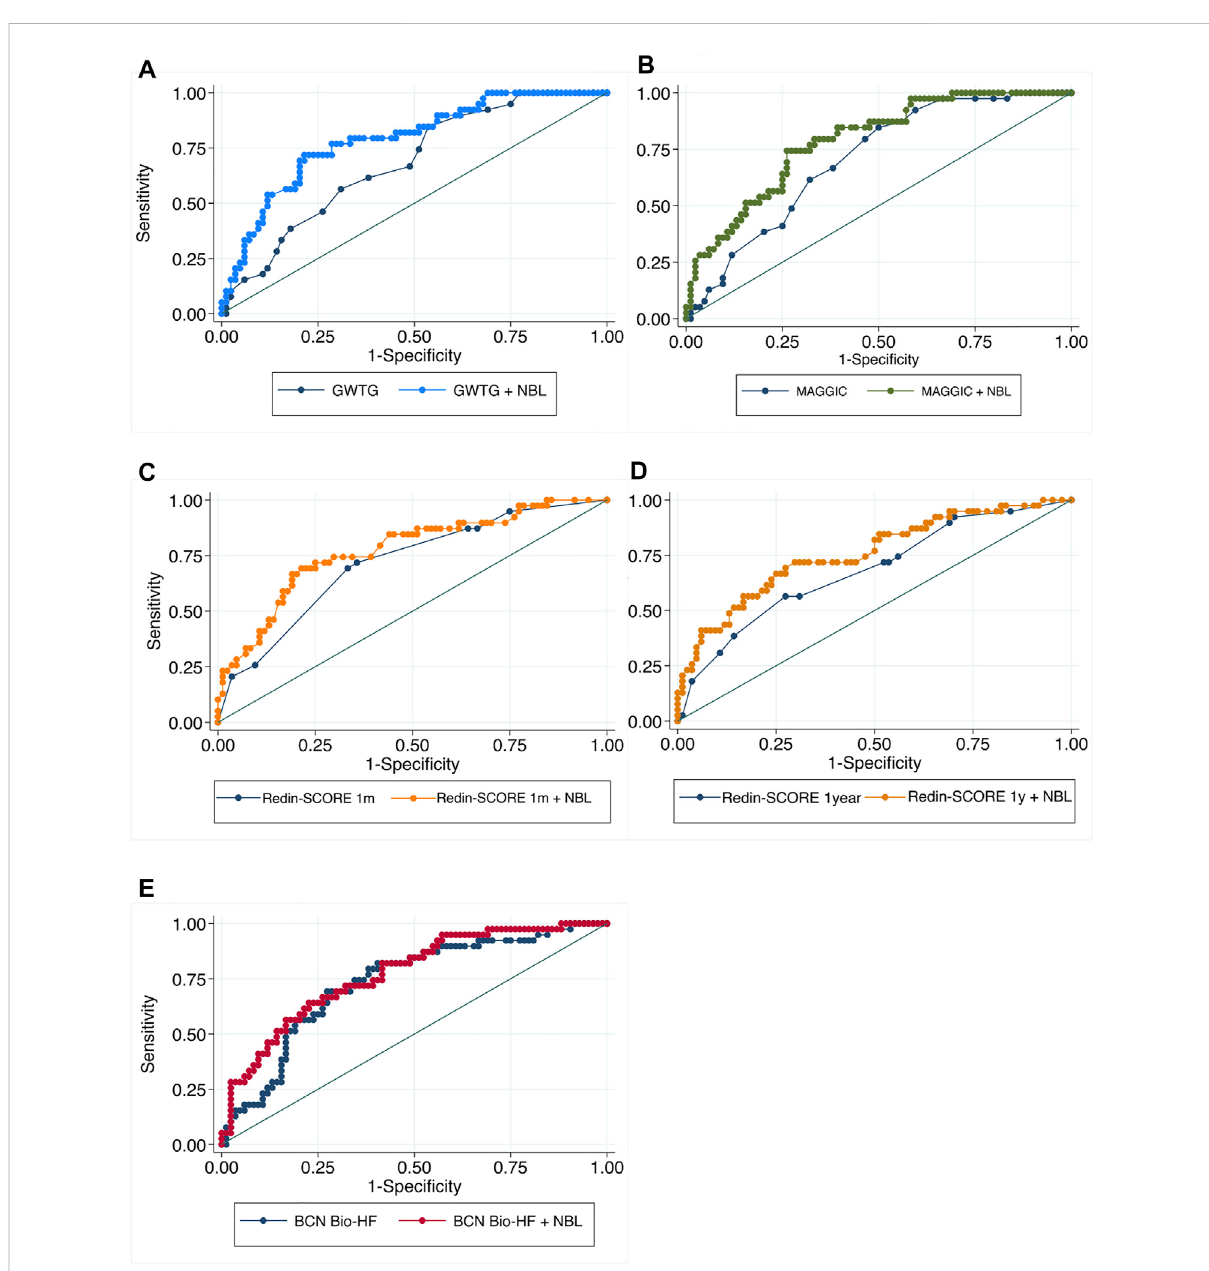
FIGURE 1 Comparison between the Receiver Operating Characteristic curves (ROC) for the composite endpoint at 6-month follow-up: score alone versusscore + numberof B-lines. ROC curves compare sensitivityversusspeci fi cityacross arangeof values fortheability ofthescore to predictthe compositeendpoint.Eachpatientisgivenascorewiththeintentionthatthetestwillbeusefulinpredictingeventoccurrenceandthedifferentpoints on the curve correspond to the different cutpoints used to determine whether the test results are positive. Adding B-lines to GWTG, MAGGIC and REDIN-Score 1 year scores (A,B,D) makes the true positive rate higher and the false positive rate lower at all cutpoints compared with the score alone. Regarding BCN Bio-HF and REDIN-Score 1 m (C,E) adding B-lines improves both sensitivity and speci fi city in almost all